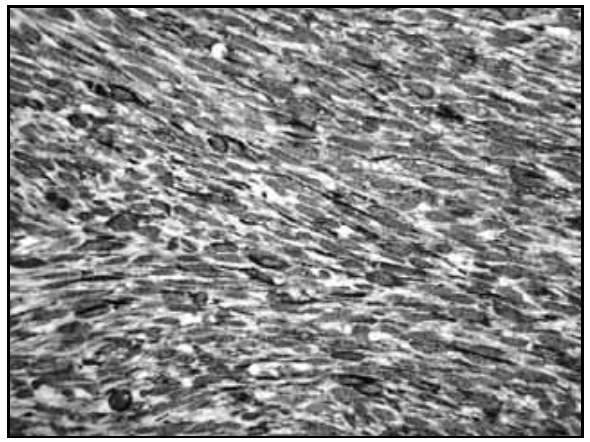
Figura 4 – Imuno-histoquímica antivimentina, com marcação forte e difusa (vimen- tina,